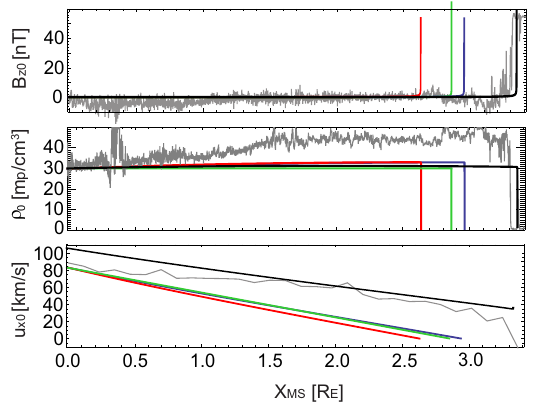
Fig. 6. Magnetosheath solutions on the stagnation streamline for the analytical (green), the numerical zeroth order (red), and the second order approach (blue). The second-order solution on the probe’s or- bit (close to but not exactly on the stagnation streamline) is shown in black, the corresponding THEMIS data of 24 August 2008 in grey. Fig. 7. Magnetosheath streamlines with the velocity obtained by solving the second-order approach. The parabolic bow shock (red) and the magnetopause (green) are delineated.